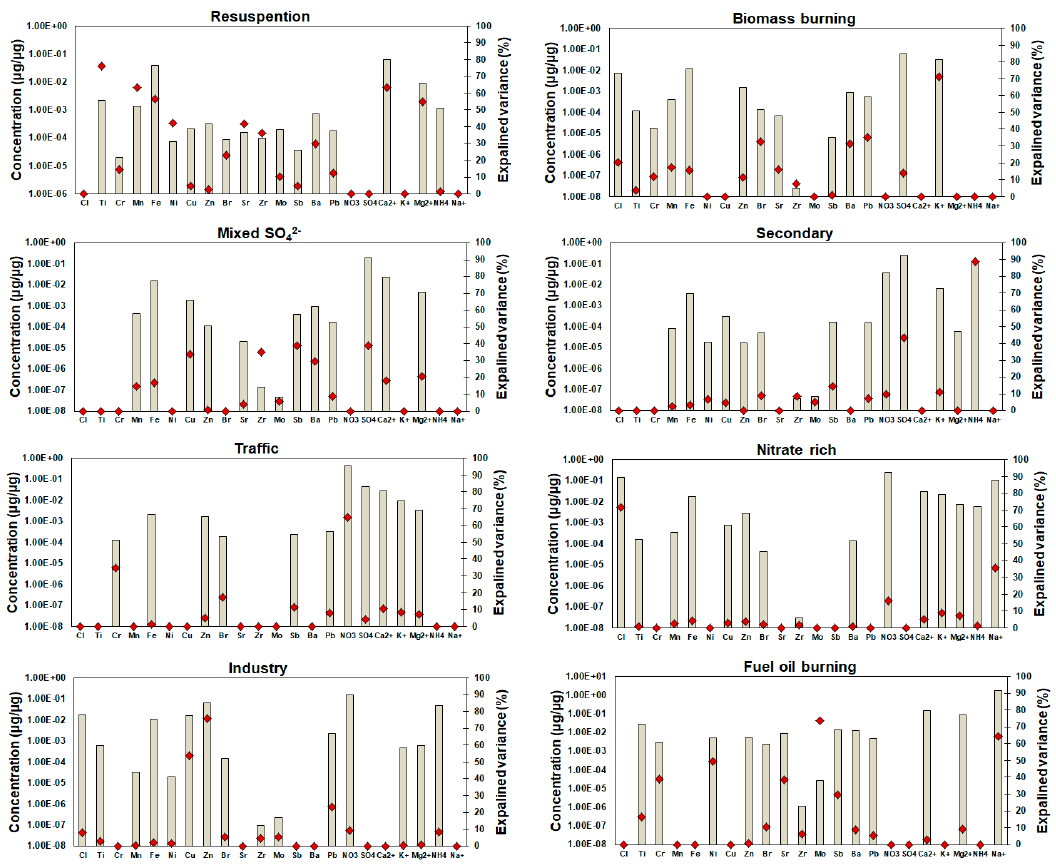
Figure 5. Factor contribution and source chemical profiles .